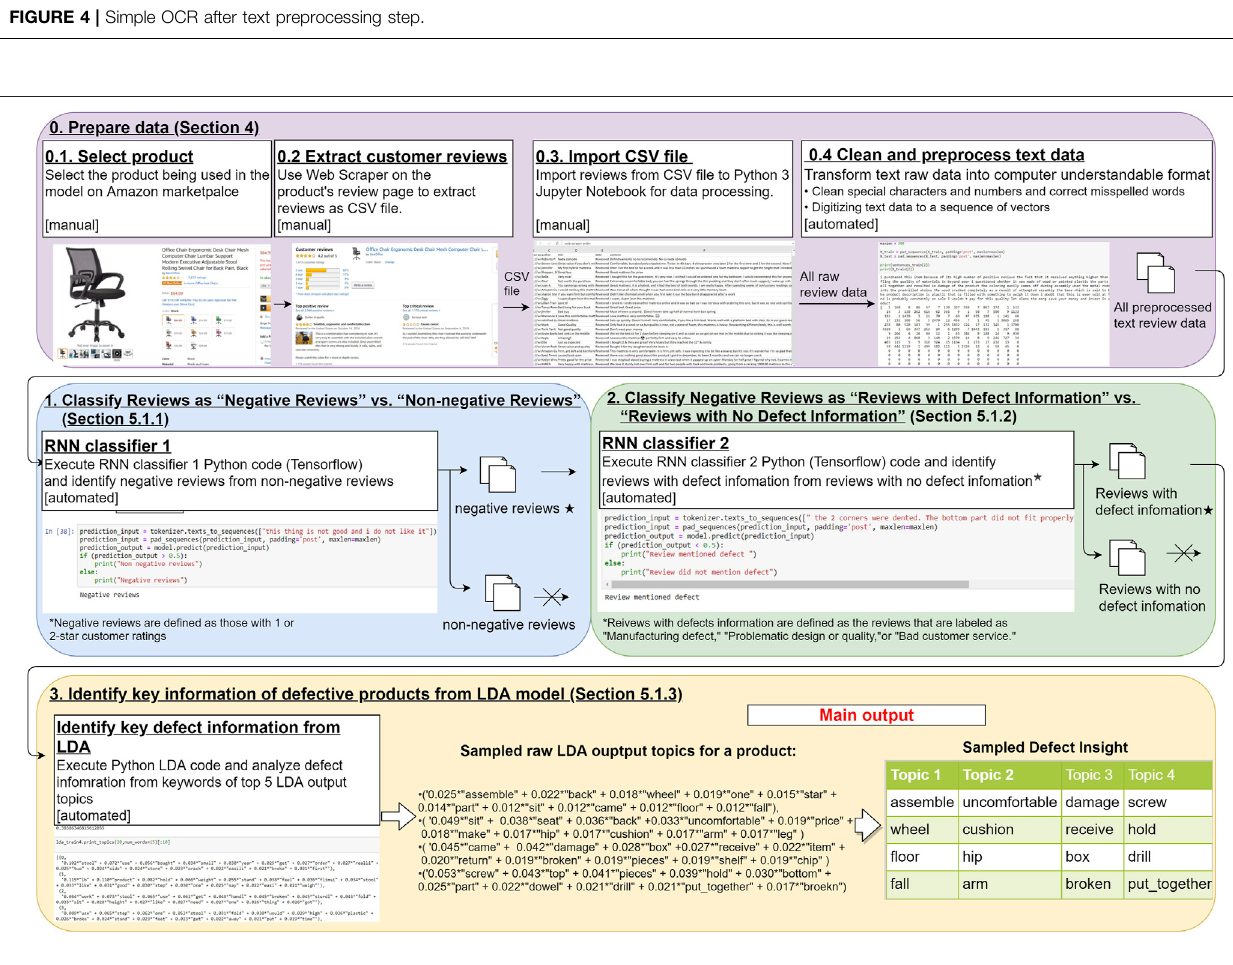
FIGURE 5 | End-to-end